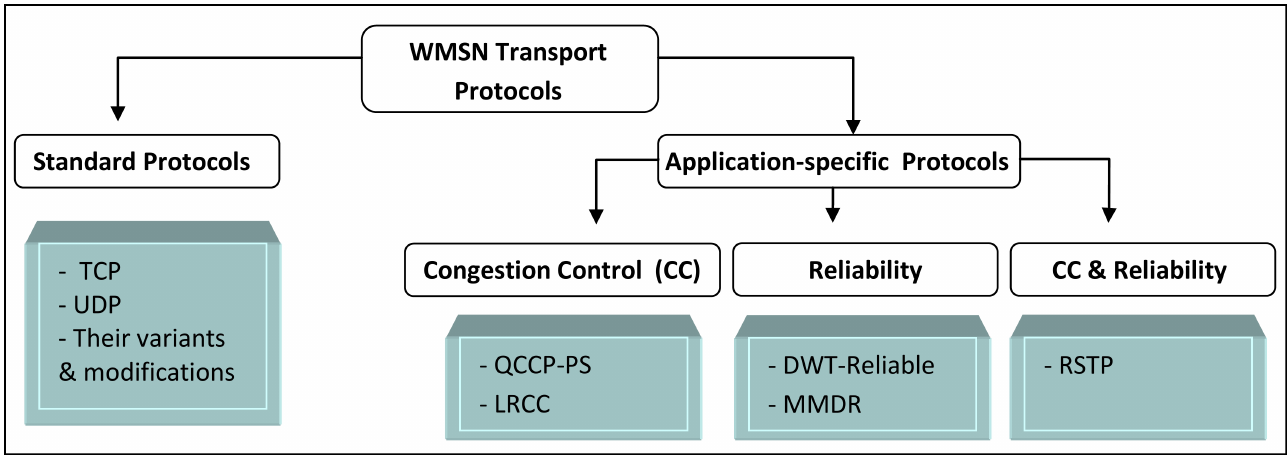
Figure 3. WMSN Transport Protocols